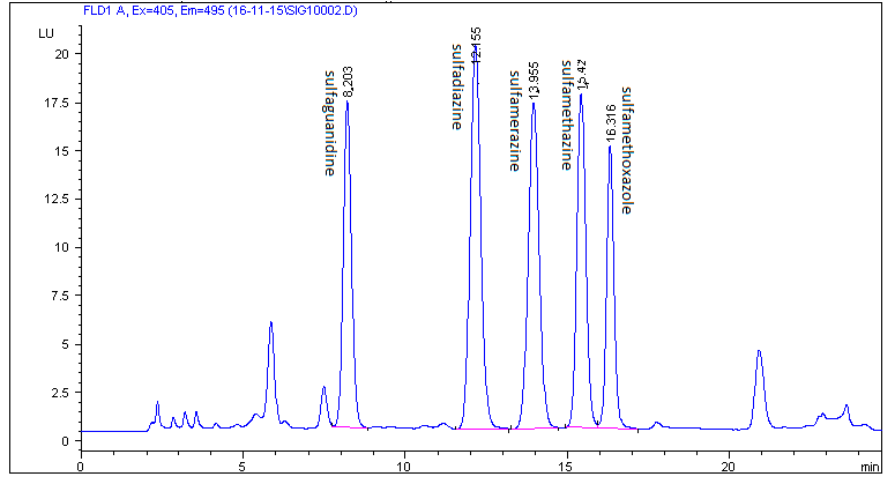
Figure 5. Chromatogram of feed sample spiked with five SAs at a concentration of 200 µg/kg on a Zorbax Eclipse XDB C18 column with a mobile phase of 0.1% acetic acid in Milli-Q